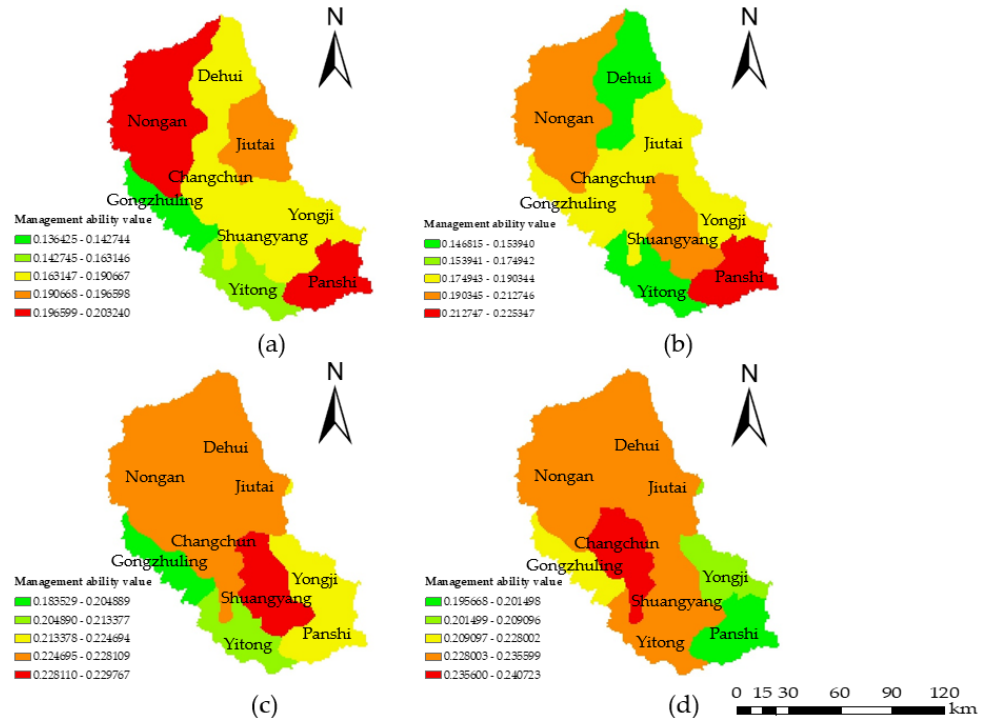
Figure 6. Water environmental regional management ability maps of ( a ) 2000; ( b ) 2005; ( c ) 2010; and ( d ) 2015. The color scale from green to red represents slightly managed, lightly managed, moderately managed, heavily managed, and extremely managed, respectively.